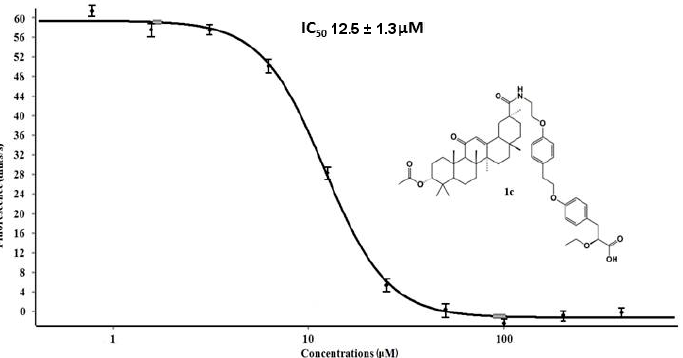
Figure 5. The dose–response curve and IC 50 value of conjugate 1c against the SARS-CoV-2 MPro.